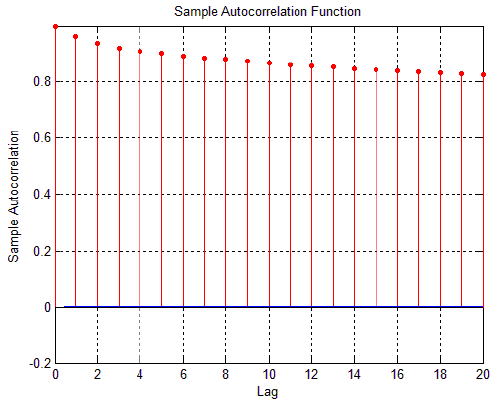
Figure 5. Sample autocorrelation function values of the wind speed data set.